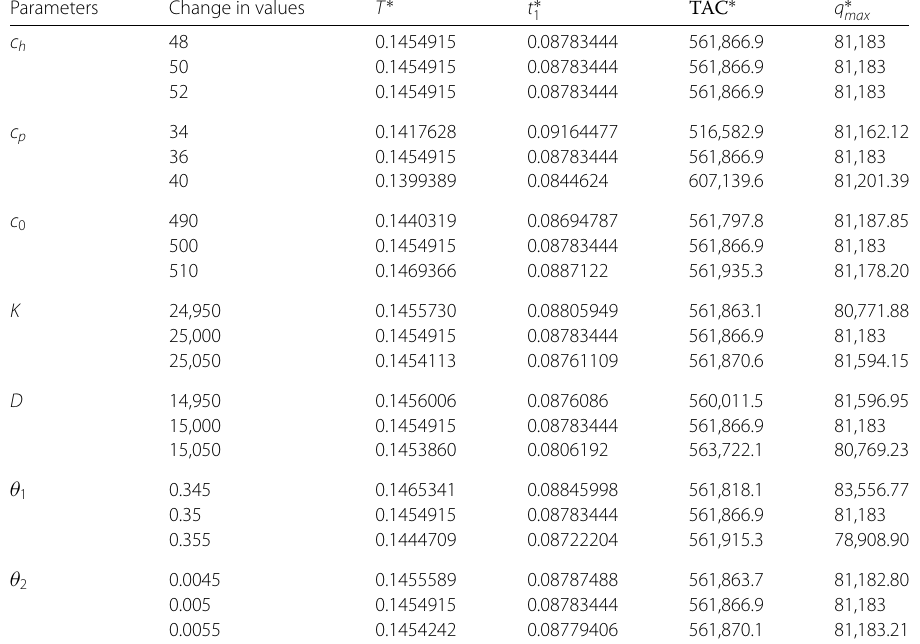
Table 9 Sensitivity table for Model